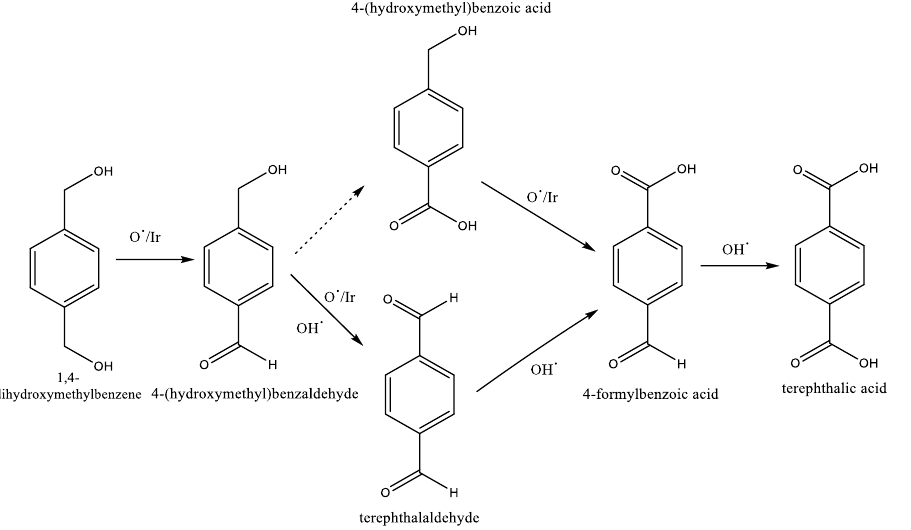
7 of 28 Figure 6. Structure of an iron(II) complex bearing a tetradentate bis(pyridyl- N- heterocyclic carbene) ligand. Adapted from [26]. Goulas et al. [27] screened the oxidation of di-hydroxymethyl benzene (DHMB) to terephthalic acid using several metals supported on carbon, such as Au, Pt, Pd, Cu, and Ir. In the first test, performed at 90 ° C and 1 bar of oxygen, Pd led to the highest conversion but low yields for the oxidation products. The same trend occurred with Pt. Both were reported to be good C-C bond scission catalysts. Metals are known for their oxidative power; for exampke, gold and copper only oxidized DHMB to HMBA, while the Ir catalyst obtained a 93% oxidation product yield, including 55% for TPA at full conversion of DHMB. When comparing all the metals at similar conversion of between 60 and 75%, Ir presented a minimal loss of carbon. Under optimized conditions, the Ir/C catalyst pro- moted the full conversion of DHMB, leading to a maximum yield of TPA of 76% after 20 h, at 100 °C, with 12 bar of O 2 . Under the same conditions, p- xylene did not react; therefore, this type of catalyst appears to be more suitable for a biomass-based processes, or later, oxidation within the full process. The authors explored the possible mechanism (Scheme 3) followed by the iridium catalyst. By subjecting the reactants and intermediate oxidation